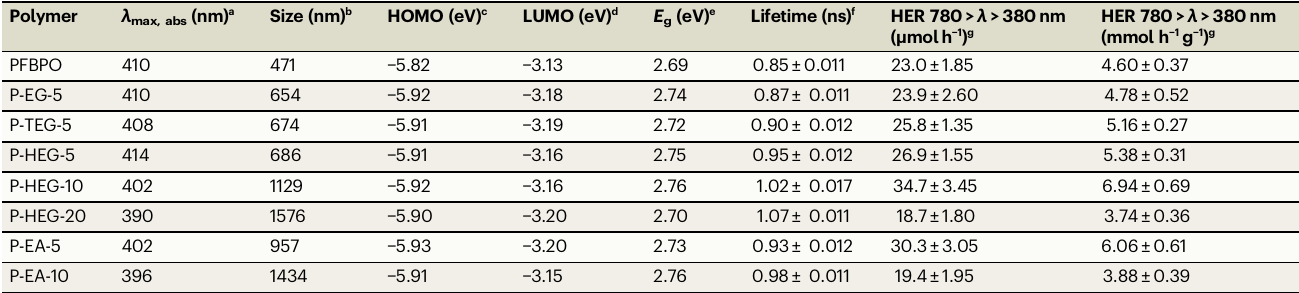
Table 1 | Photophysical properties and HERs of various polymers Polymer